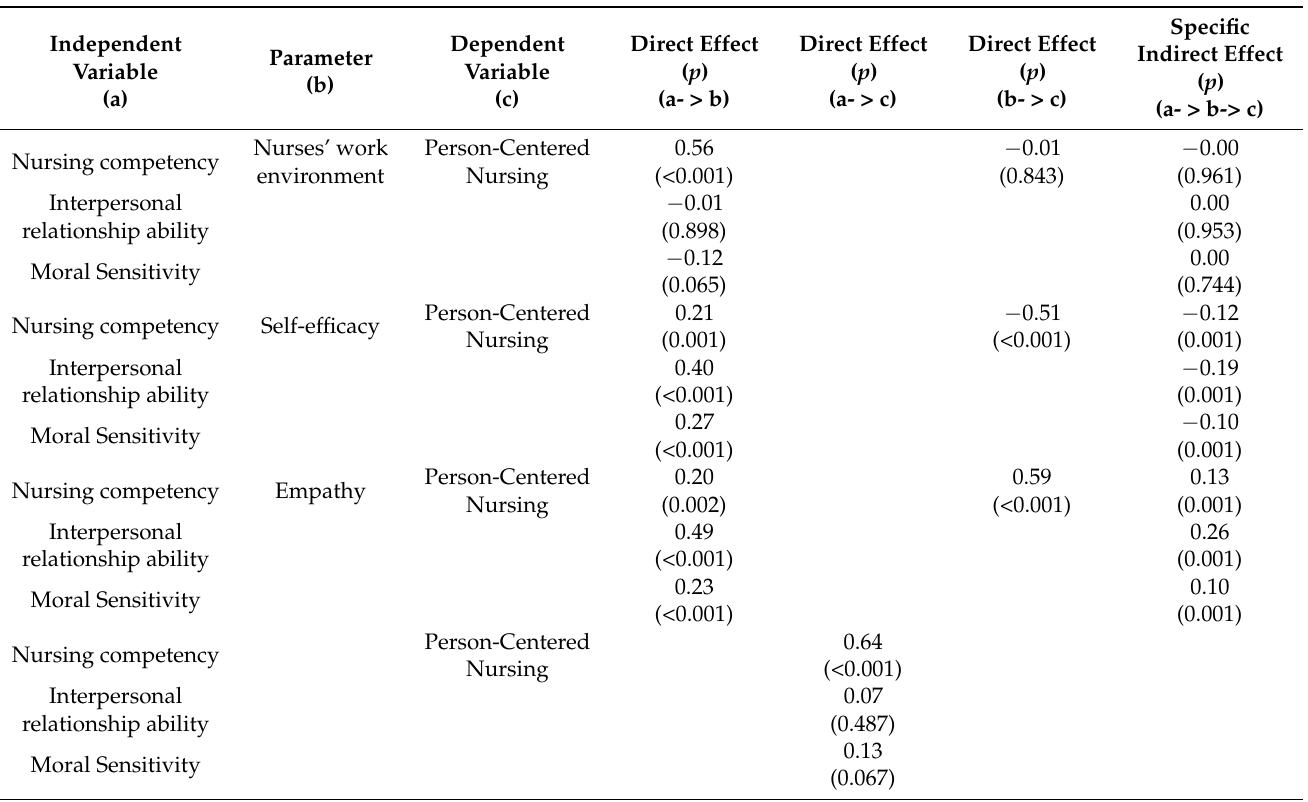
Table 3. Standardized direct, indirect effects for the Hypothetical